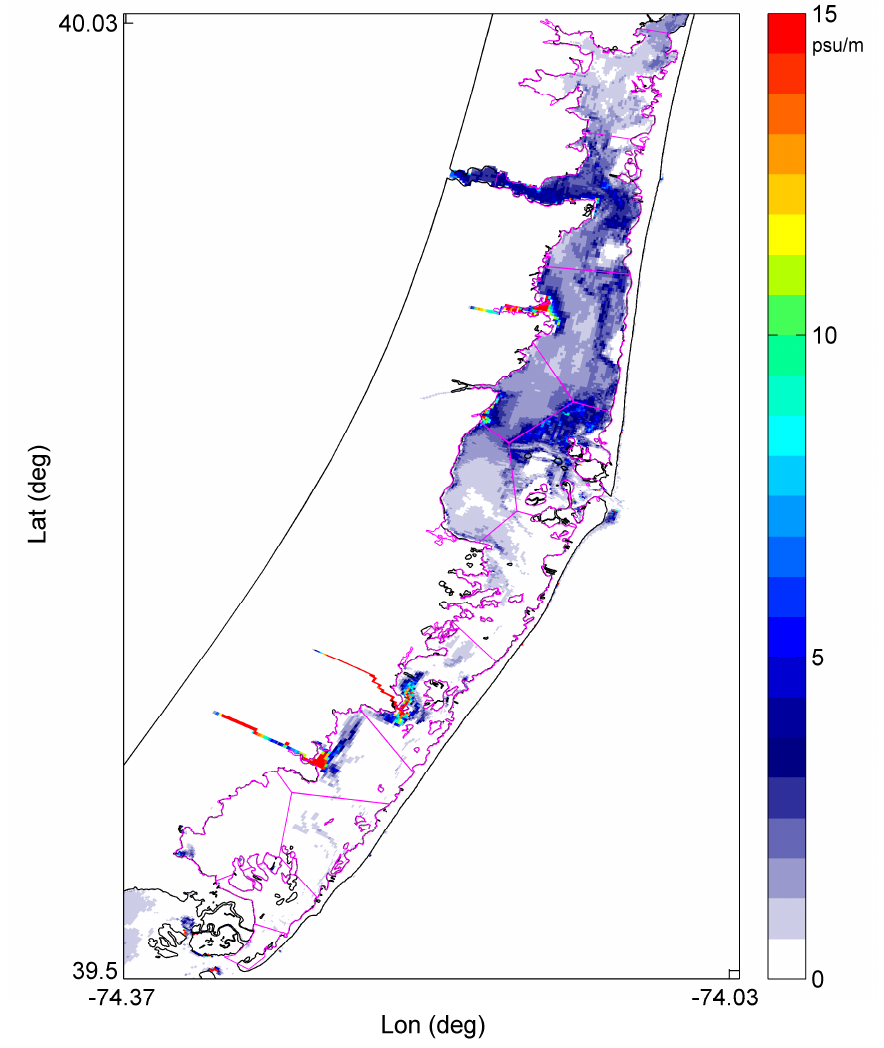
Figure 3. Maximum vertical salinity gradient in the water column from the hydrodynamic model over the 22 day simulation period. Gradients above 5 and 1.2 (psu / m) altered the behavior of clam and oyster particles respectively. Magenta lines designate polygons with particle releases occurring at each centroid.